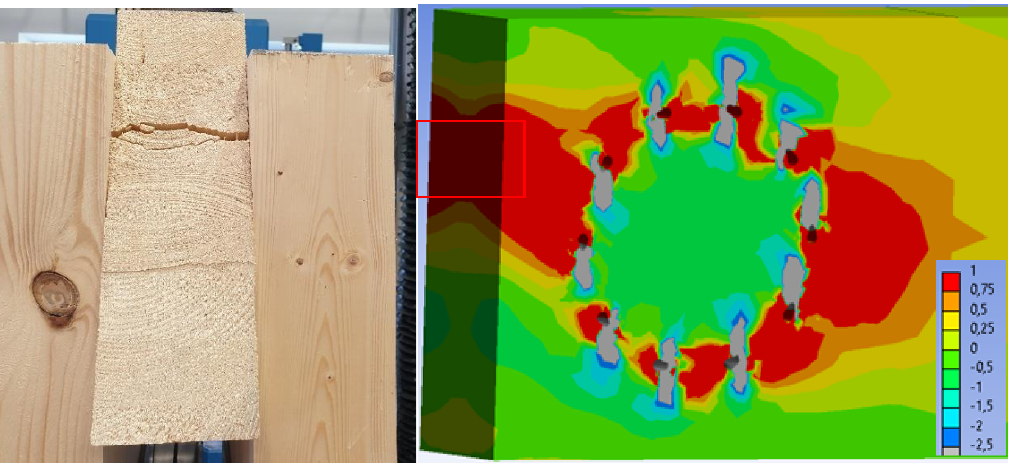
Figure 31. Experiment B: Collapse of the connection during experimental testing (on the ( left )), tensile stress perpendicular to the grain from the numerical model (MPa) (on the ( right )).